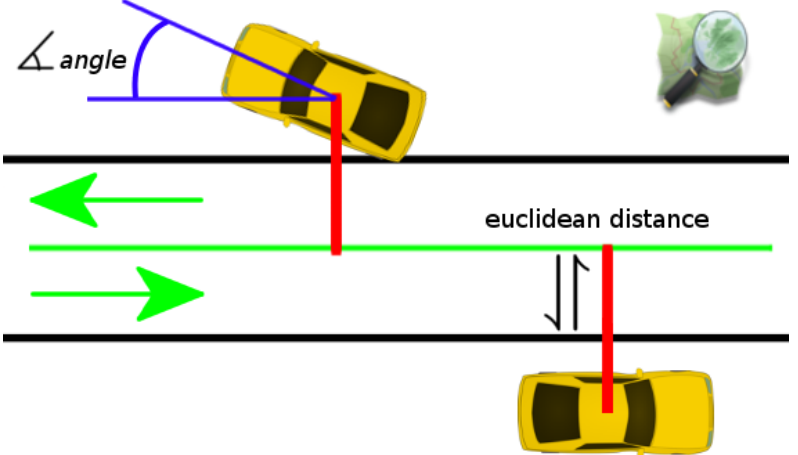
Figure 7. The primary lock-on-road component implemented in the first Road Layout Estimation framework [28]. The score of this component contributes to the LH evaluation considering the distance (the red line) with respect to the nearest road segment (the green line) and the angular misalignment (the blue arc), which also includes the road driving